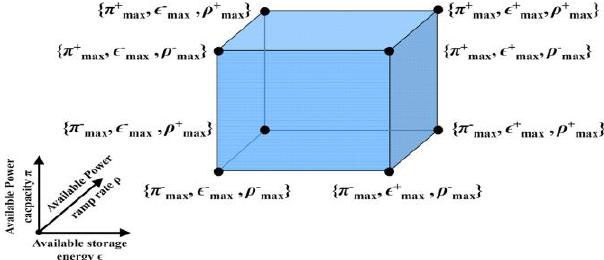
Figure 2. The flexibility cube of a generic power system unit with maximum available operational